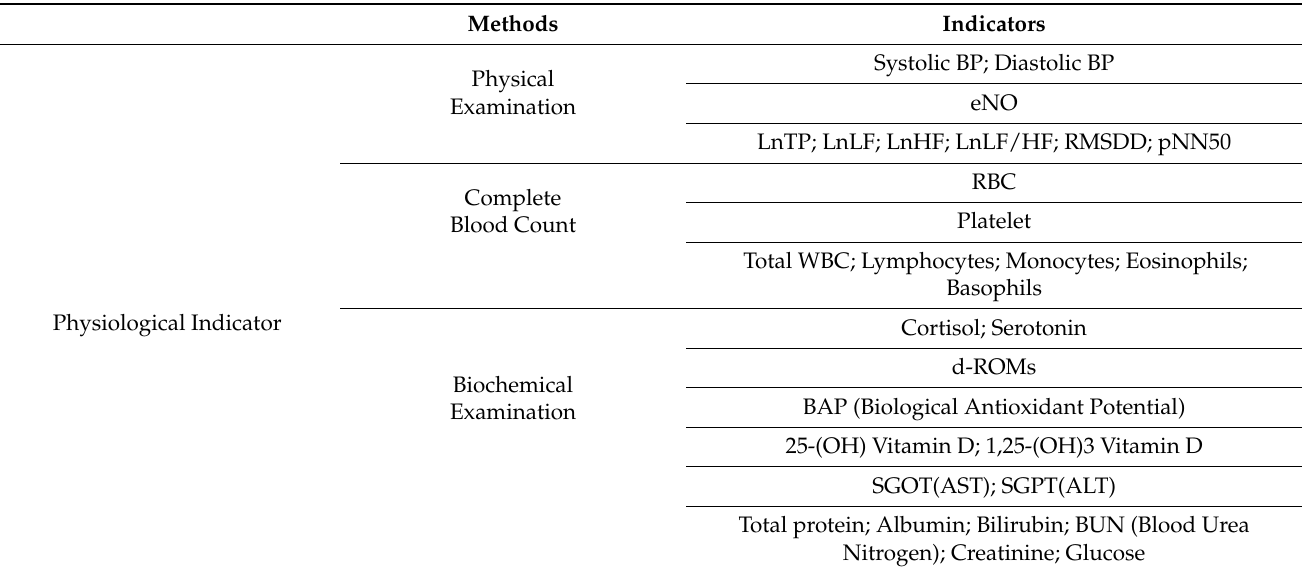
Table 5. Measurement